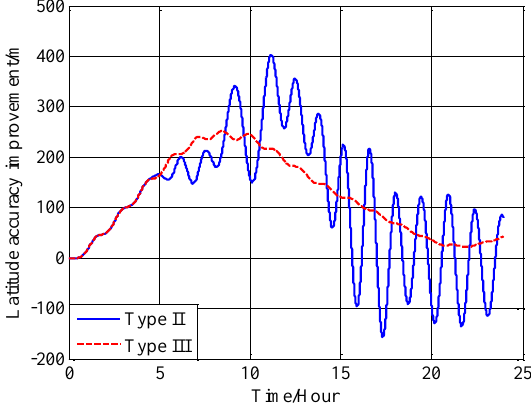
Figure 19. The precision improvement of latitude with compensation.